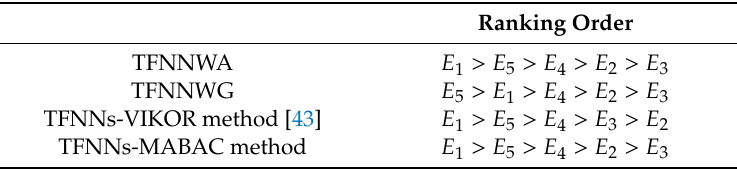
Table 13. The results of ranking order of